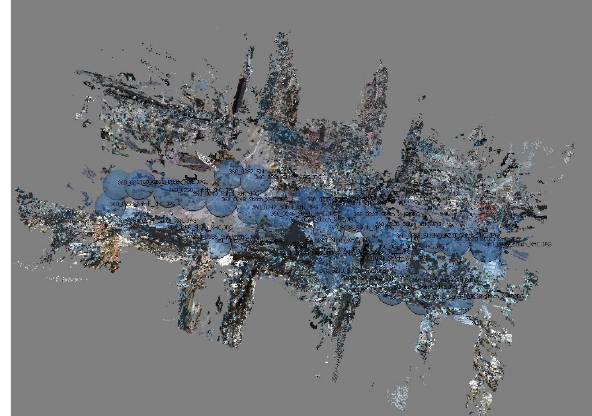
Figure 3: Alignment of the spherical panoramas from Samsung Gear 360 and dense cloud processing.